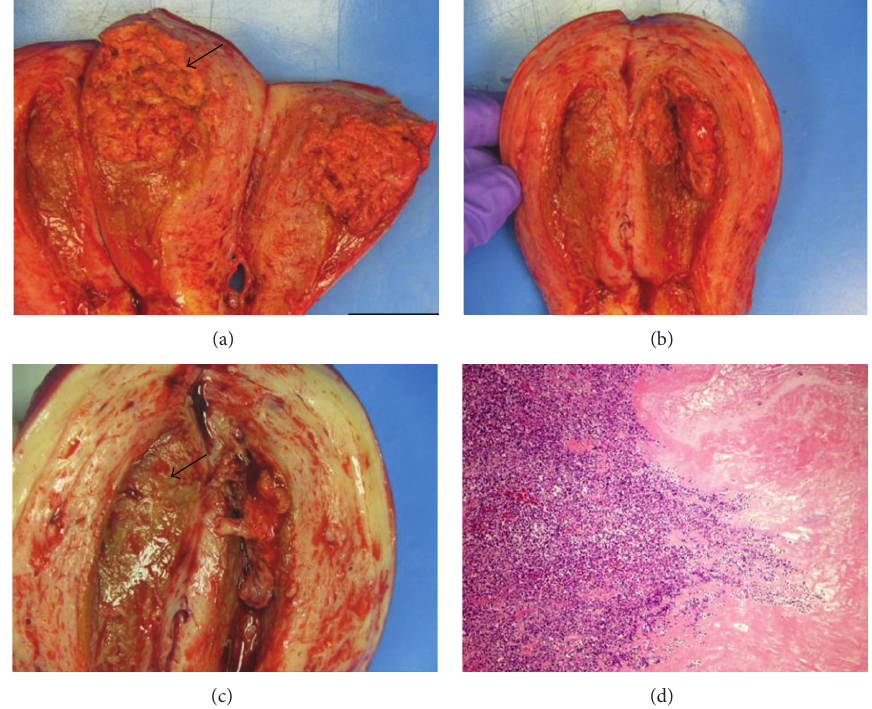
Figure 2: A tan fungating necrotic tumor in the anterior uterine wall (arrow) ((a) and (c)); low power microscopic section shows extensive necrosis and acute inflammation at the surface of tumor ((d) H&E, × 20).